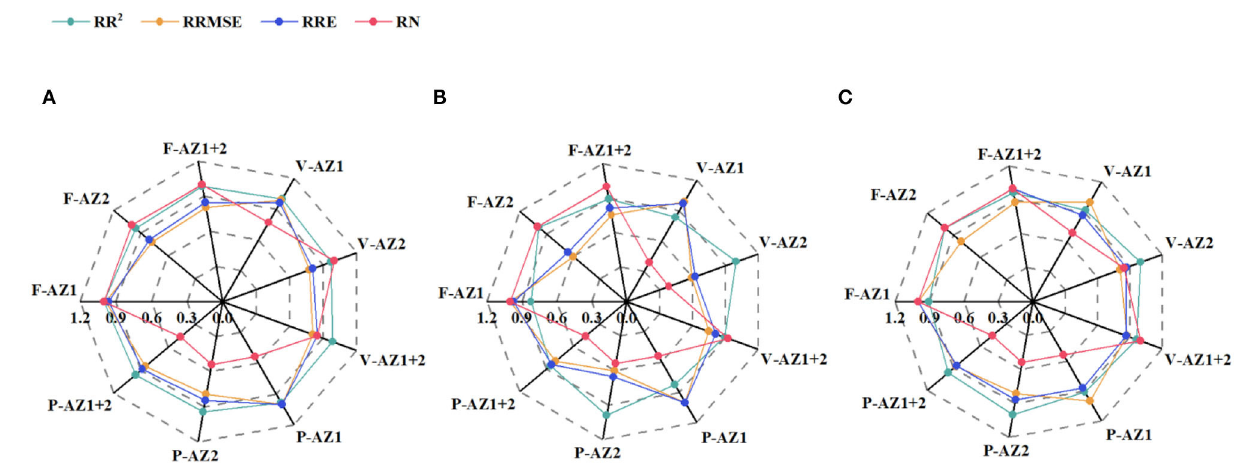
FIGURE 7 | The accuracy of random forest regression (RFR) on aboveground biomass (A) , plant N uptake (B) , and N nutrition index (C) using two variable selection strategies and full variables. F-AZ1 represents full variables in agro-ecological zone 1, P-AZ1 represents selected variables by Pearson correlation coefficient strategy in agro-ecological zone 1, V-AZ1 represents selected variables by the variable importance ranked by the RFR strategy in agro-ecological zone 1; similarly, F-AZ2, P-AZ2, V-AZ2, F-AZ1 + 2, P-AZ1 + 2, V-AZ1 + 2 represents full variables, selected variables by Pearson correlation coefficient strategy and the variable importance ranked by the RFR strategy in agro-ecological zone 2 and across two agro-ecological zones, respectively. RR 2 , RRMSE, RRE, and RN represent the relative coefficient of determination, relative root mean square error, relative error, and the relative number of variables,